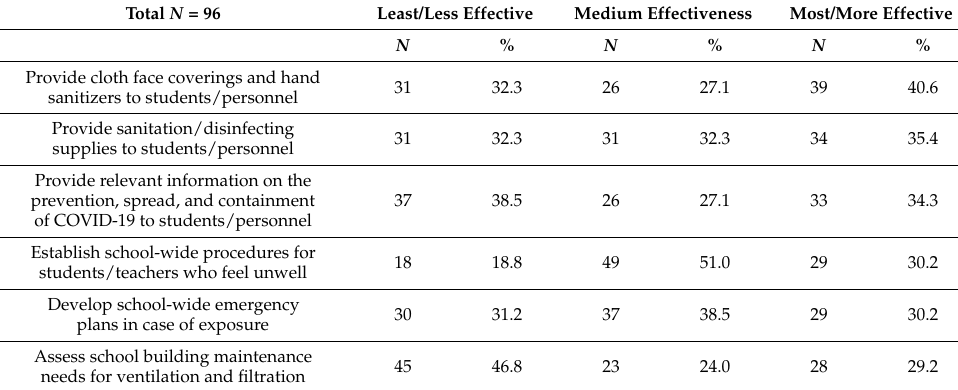
Table 1. Initiatives school systems can take to get back to school safely. Data presented for the overall study sample. Fisher’s exact tests were used to document how, for each initiative, there were no statistically significant differences statewide by regions of New Jersey (NJ) or when stratified by the reported